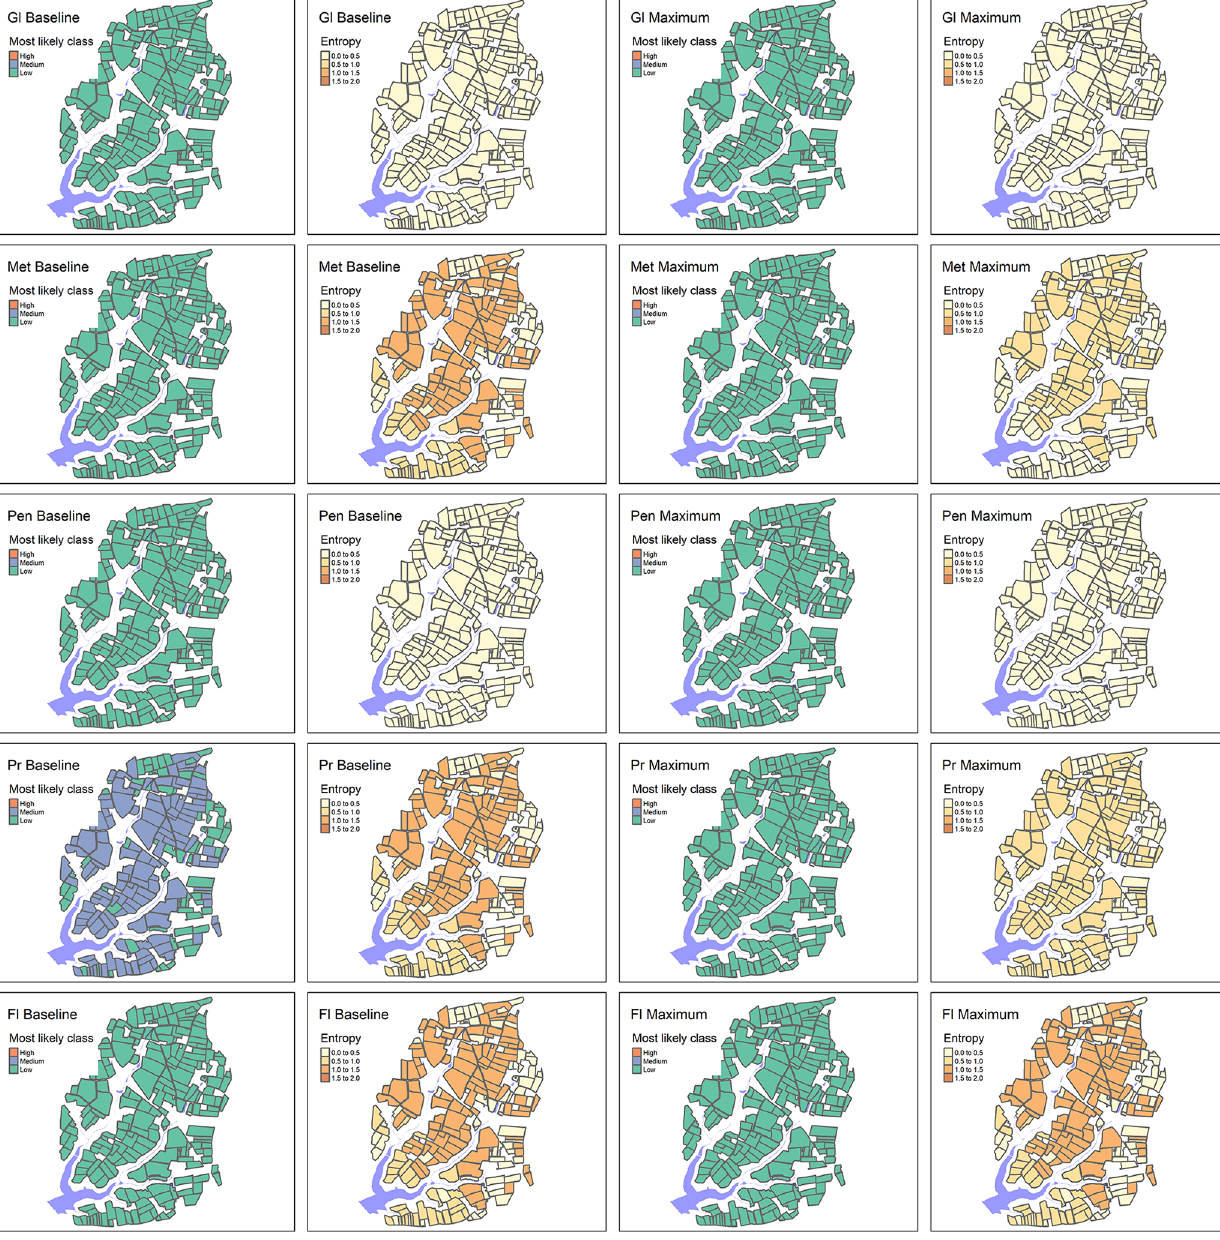
Figure 4. Spatial variability and associated uncertainty (entropy) in the groundwater leaching risk under current practices for the five active ingredients under baseline and maximum mitigation scenarios: Gl – glyphosate, Met – metobromuron, Pen – pendimethalin, Pr – prosulfo- carb, and Fl –